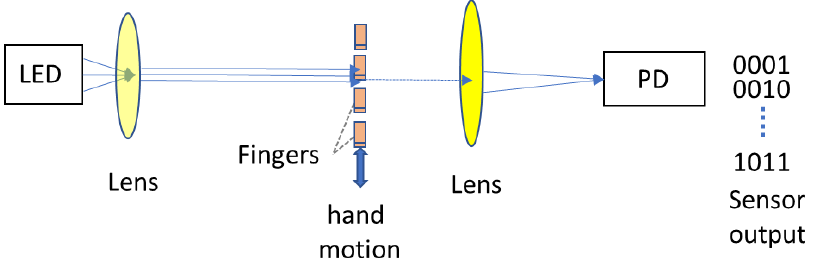
Figure 2. Concept of finger movement recognition system based on received patterns of light on a photo-diode